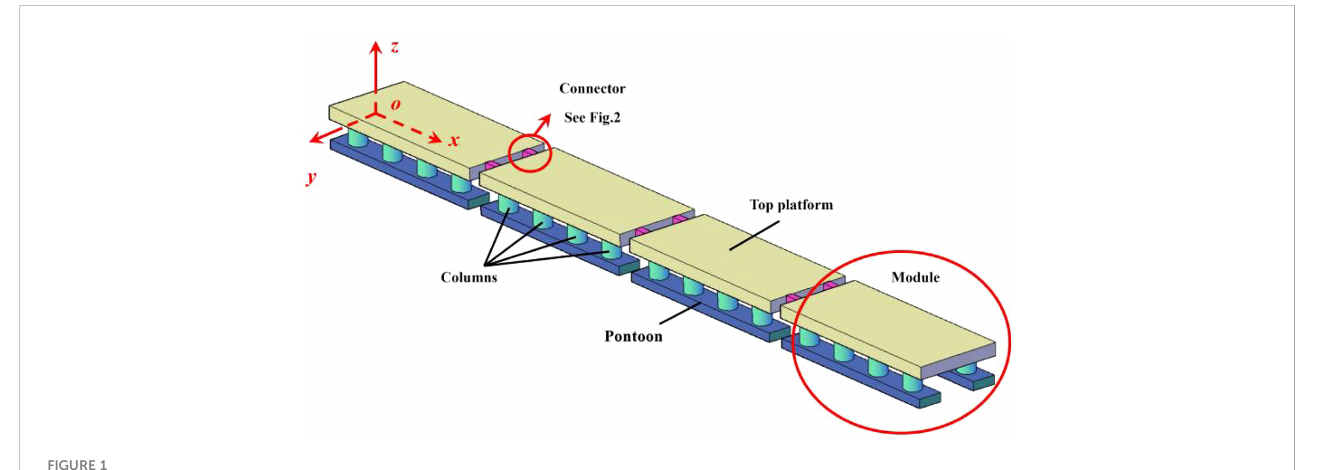
FIGURE 1 Conceptual design scheme for